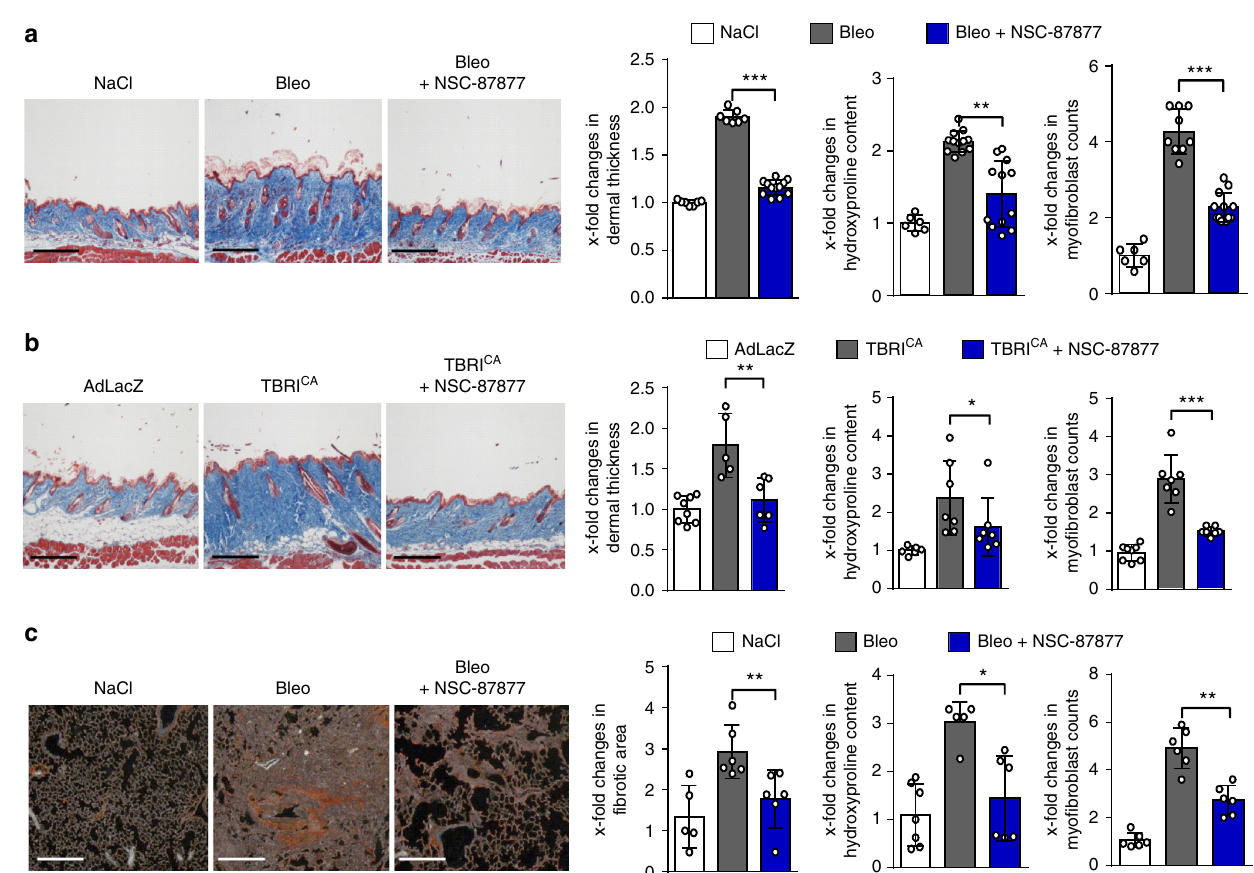
Fig. 9 Treatment with NSC-87877 ameliorates experimental fi brosis. The SHP1/SHP2 inhibitor NSC-87877 was applied at doses of 5 mg/kg q.d. a Bleomycin-induced skin (50 µ g every other day) fi brosis: representative images of Masson trichrome-stained skin shown at 100-fold magni fi cation. Dermal thickness, hydroxyproline content and myo fi broblast counts. b TBRI CA -induced (6.67 × 10 7 IFUs every 2 weeks) skin fi brosis: representative images of Masson trichrome-stained skin shown at 100-fold magni fi cation. Dermal thickness, hydroxyproline content and myo fi broblast counts. c Bleomycin-induced lung fi brosis (50 µ g single doses): representative images of Sirius red-stained lung shown at 100-fold magni fi cation. Quanti fi cation of Sirius red-positive area ( fi brotic area), hydroxyproline content and myo fi broblast counts. All groups in all models consisted of ≥ 5 mice each. Horizontal scale bar in all images, 500 μ m. All data are presented as median± s.e.m. The p values are expressed as follows: 0.05 > p > 0.01*; 0.01 > p > 0.001**; p < 0.001***. Signi fi cance